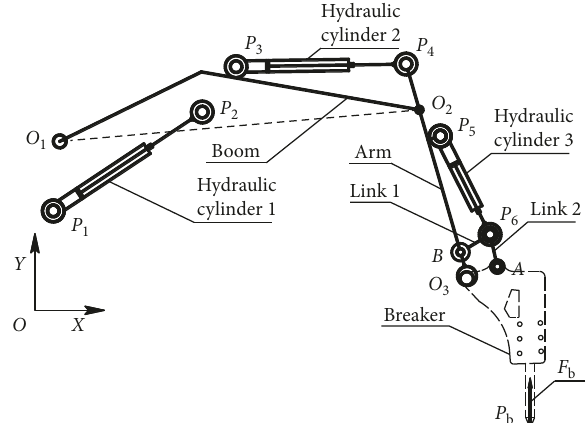
Figure 1: Rock-breaker model with clearance joints.